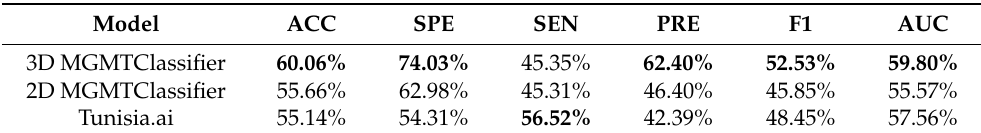
Table 2. 5- fold CV performances of models trained and tested on dataset B . The input sequence is KBF for both the 3D and 2D MGMTClassifier models and T1-w CE for the Tunisia.ai one. For each metric, the best value is reported in bold.